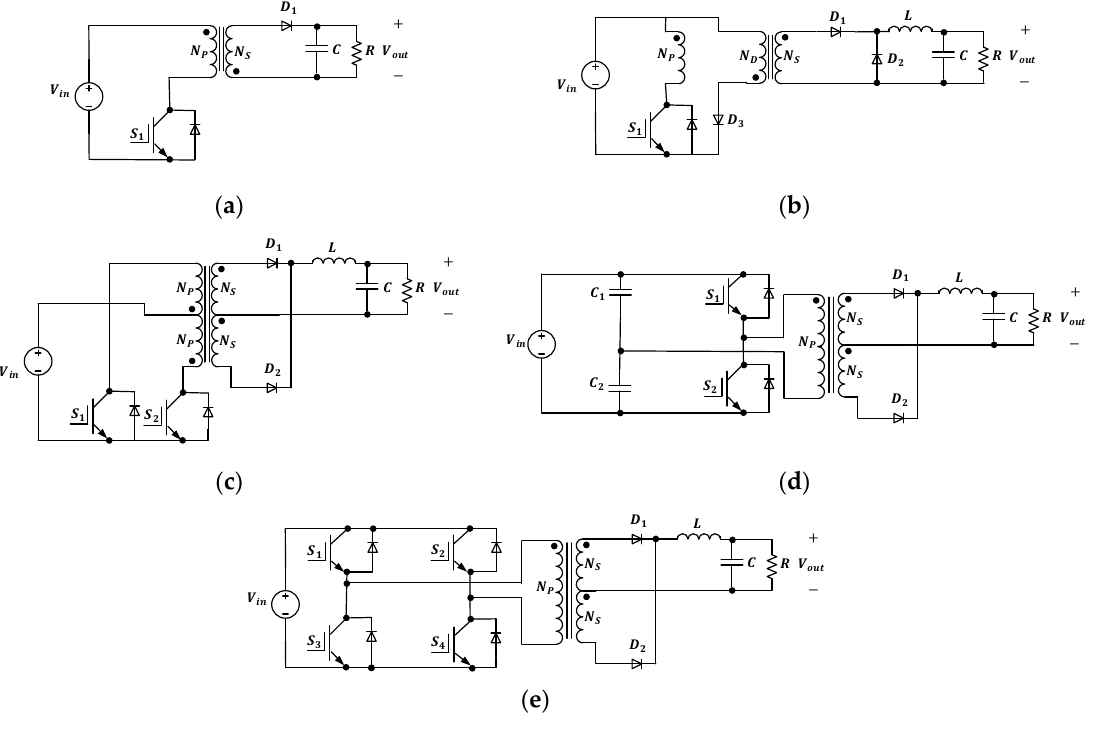
Figure 5. Basic isolated DC-DC converters: ( a ) Flyback converter; ( b ) Forward converter; ( c ) Push-Pull converter; ( d ) Half-Bridge converter; ( e ) Full-Bridge converter.